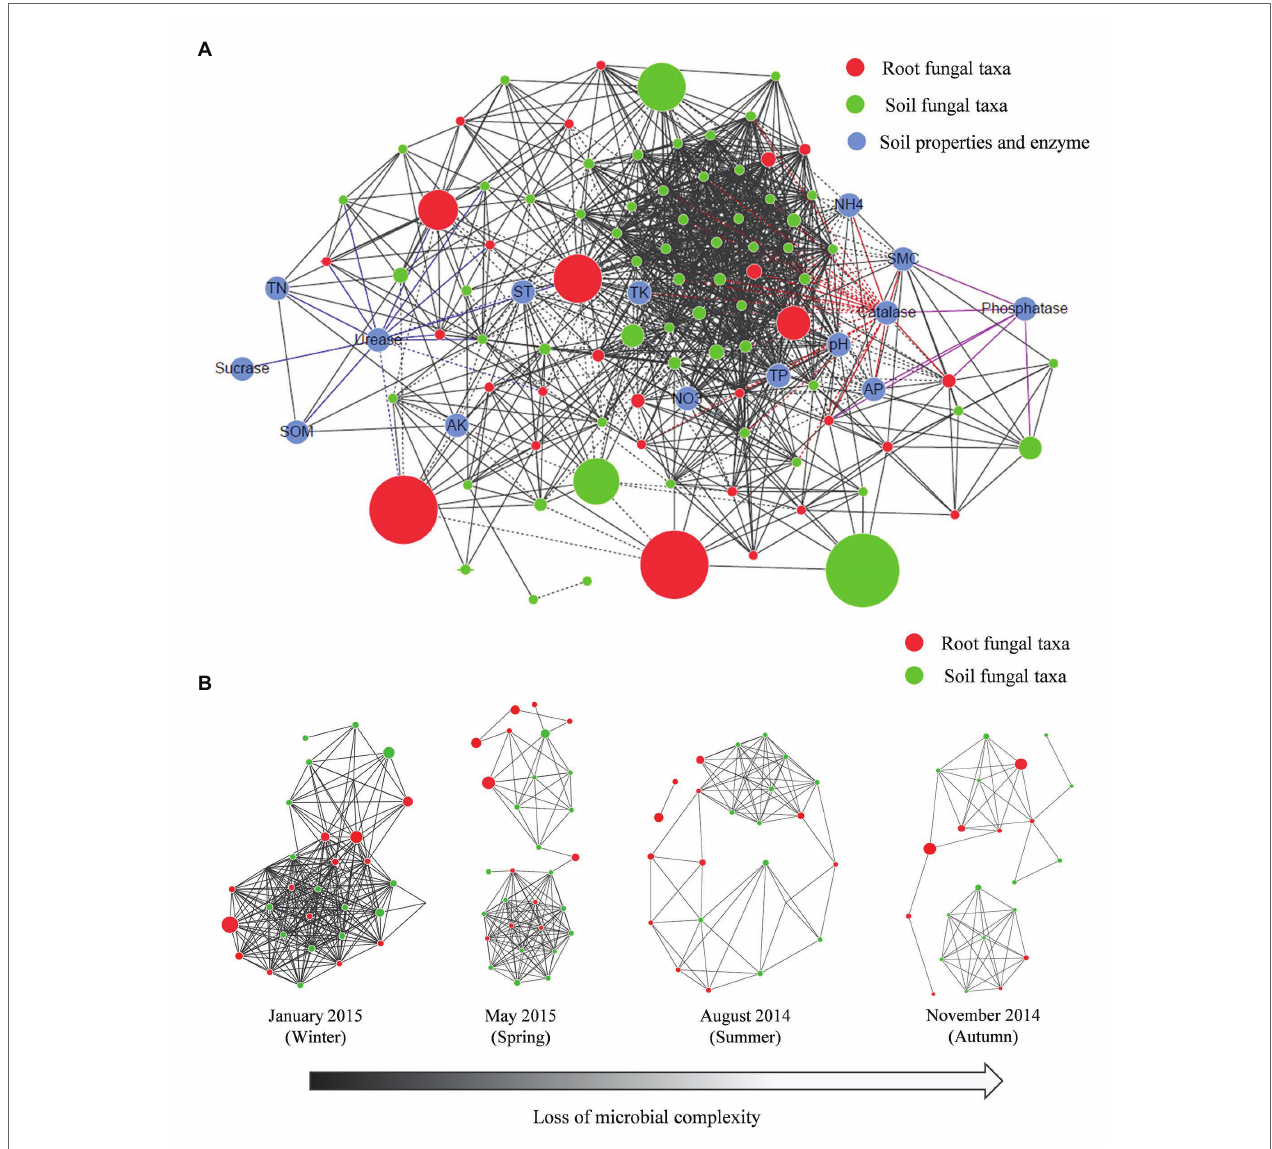
FIGURE 7 | Network analysis showing the connectedness and complexity of fungal communities. (A) Network analysis between the fungal communities and edaphic factors in P. tabuliformis forests located in the Qinling Mountains; (B) network analysis showing the root-associated fungal connectedness and complexity along seasons across the year. A strong (Spearman’s ρ > 0.6) and significant ( p < 0.01) linear relationship was observed. In the co-occurring network, colors indicate soil fungal taxa (green), root fungal taxa (red), and edaphic properties (blue); black lines indicate the significant connections between nodes, and colored lines indicate the fungal taxa that are significantly correlated with urease, catalase, and phosphatase. The sizes of nodes indicate the relative abundance of fungal taxa, solid lines indicate positive correlations, and dashed lines show negative correlations between